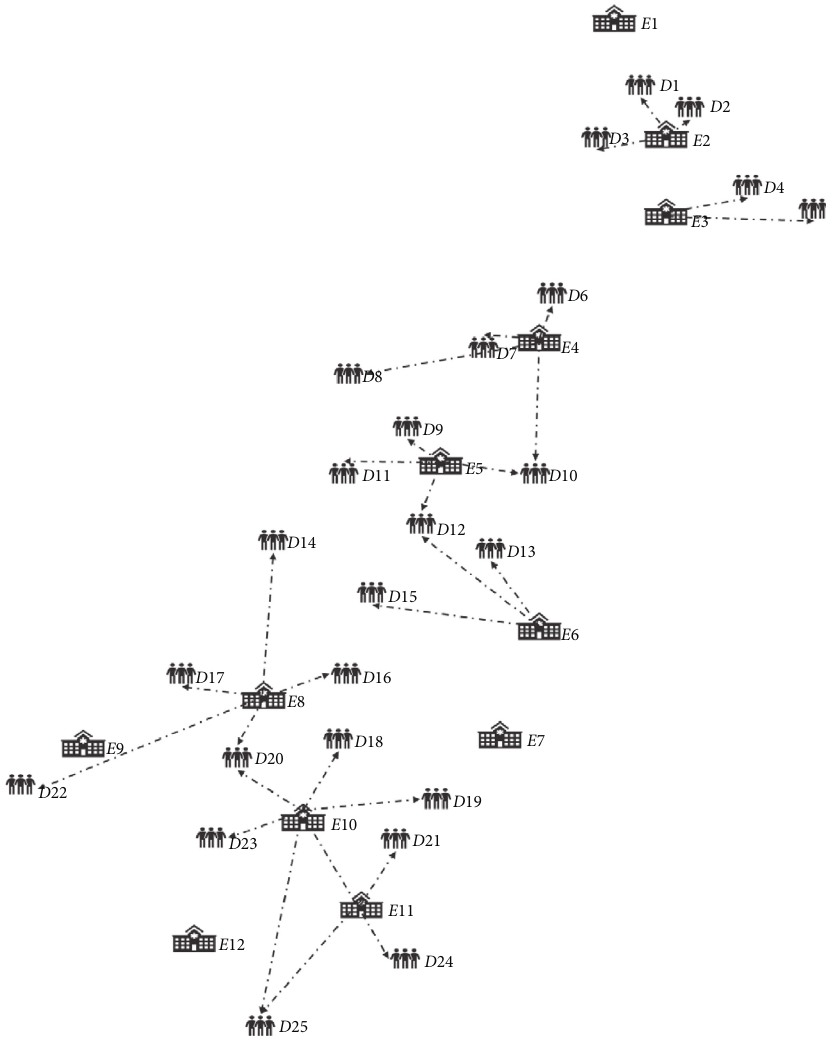
Figure 6: MIRP-box